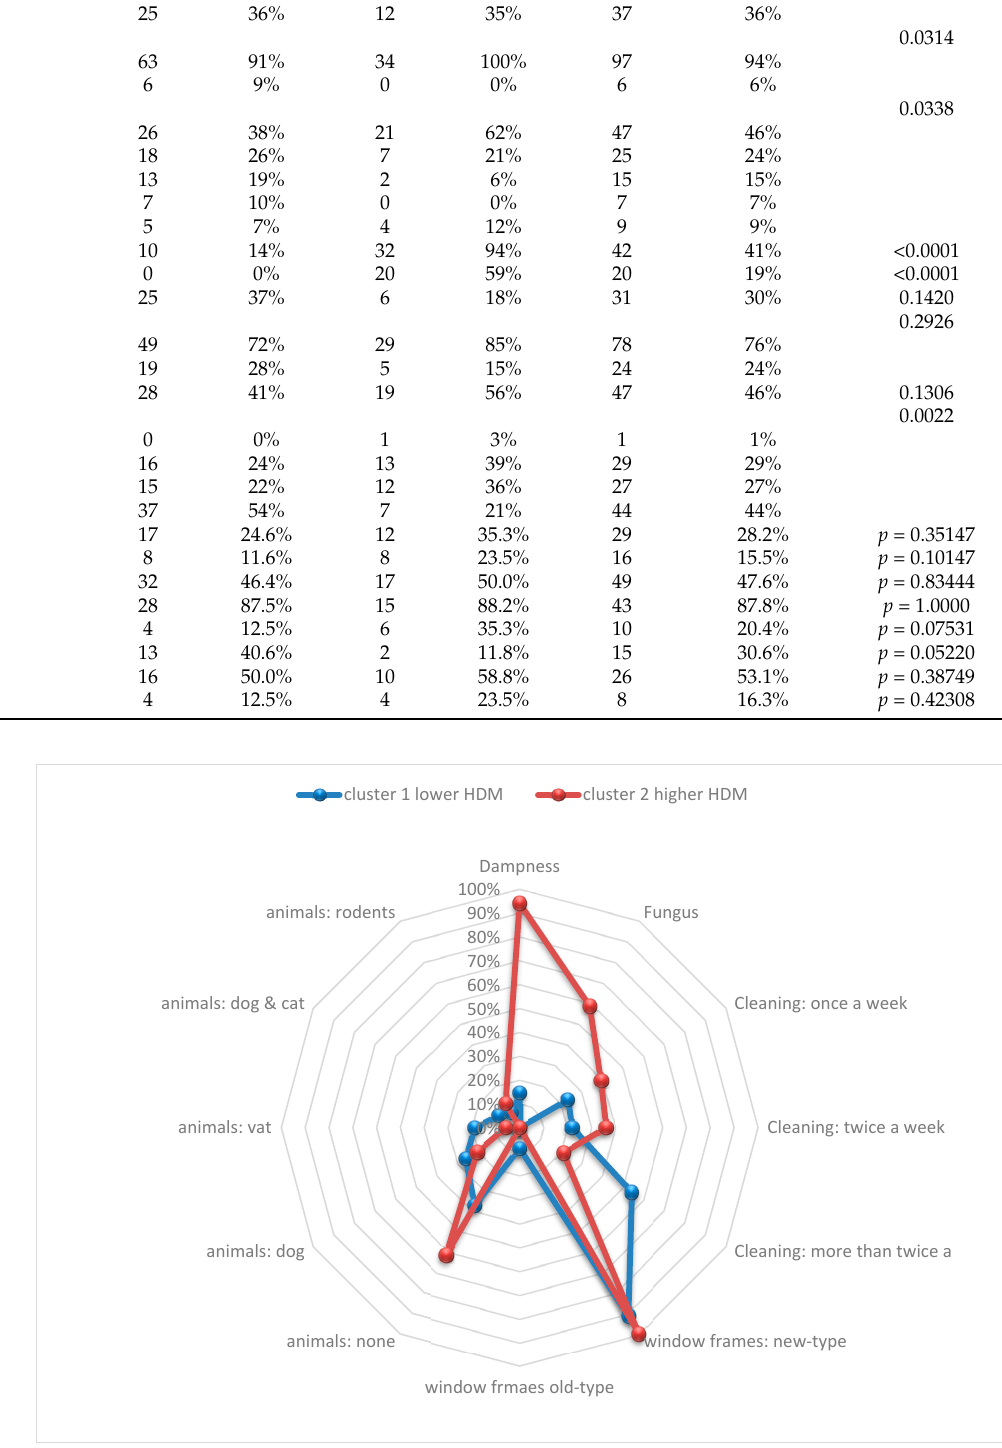
Figure 1. Environmental exposure characteristics according to cluster analysis.